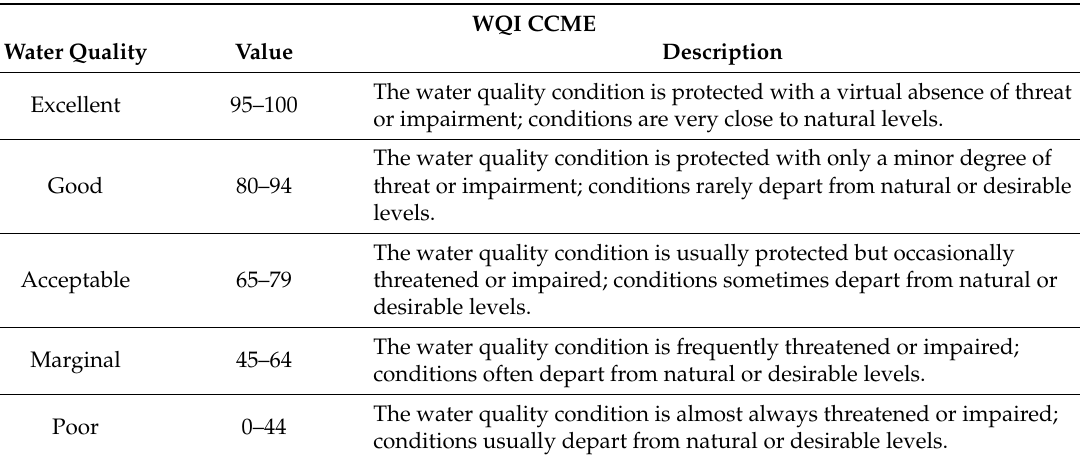
Table A3. WQI CCME classification